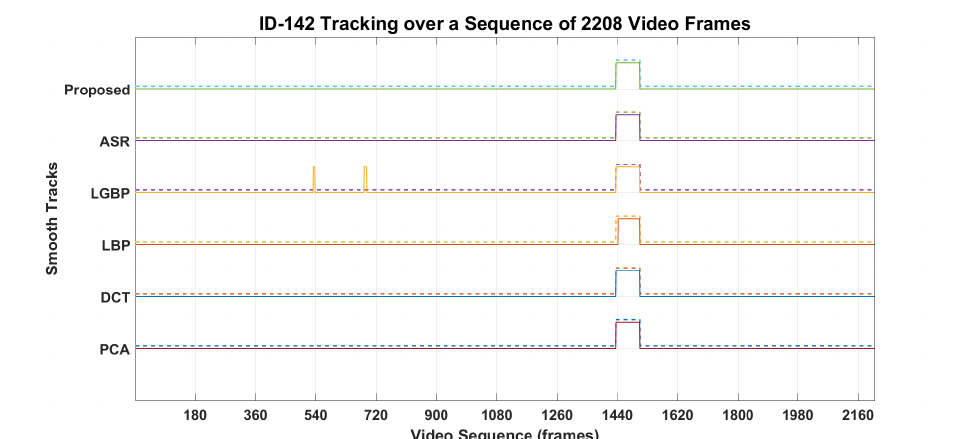
Figure 11. Tracking results of ID-142, where both rough and smooth presence tracks are shown. (The dashed lines represent manual and solid lines the system generated tracks)